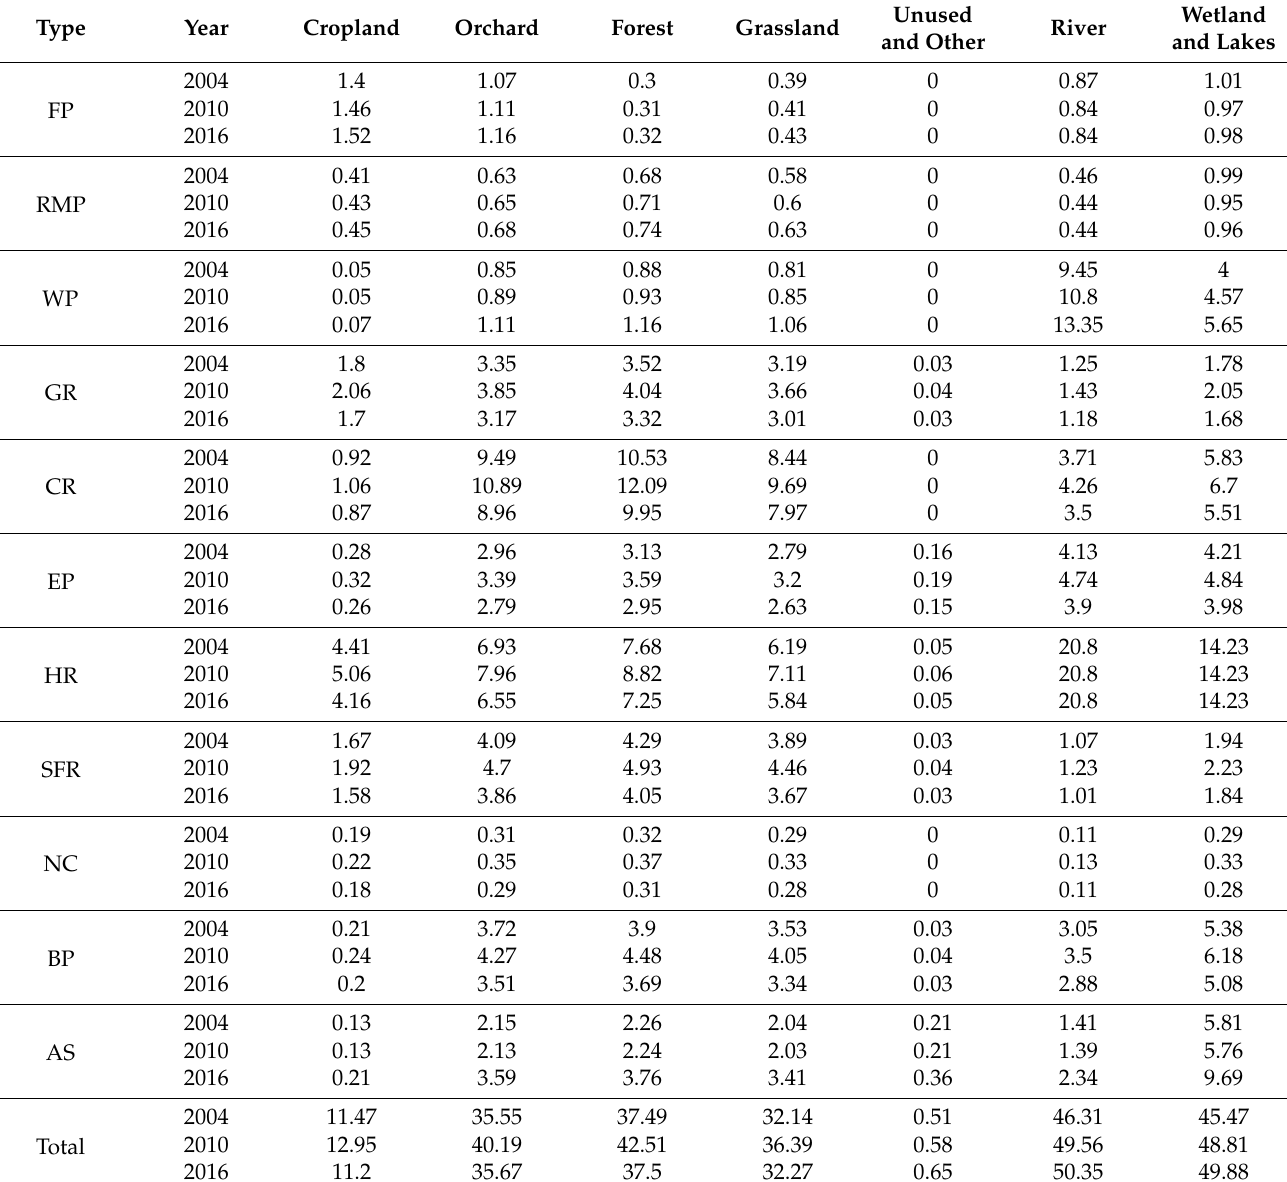
Table 5. The ESEV of various land use and ecosystem service